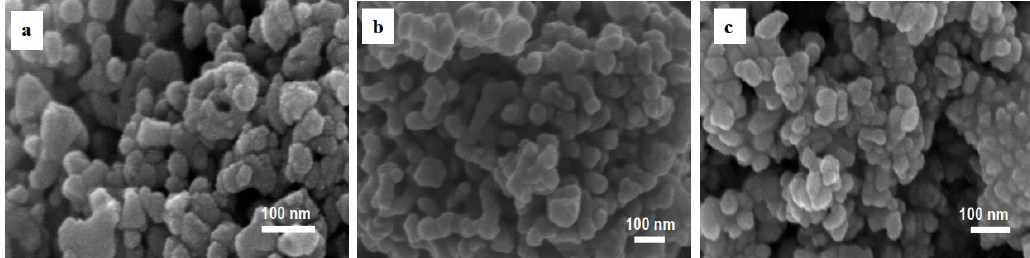
Figure 1. The scanning electron microscope (SEM) image of the ( a ) as-synthesized oxide from